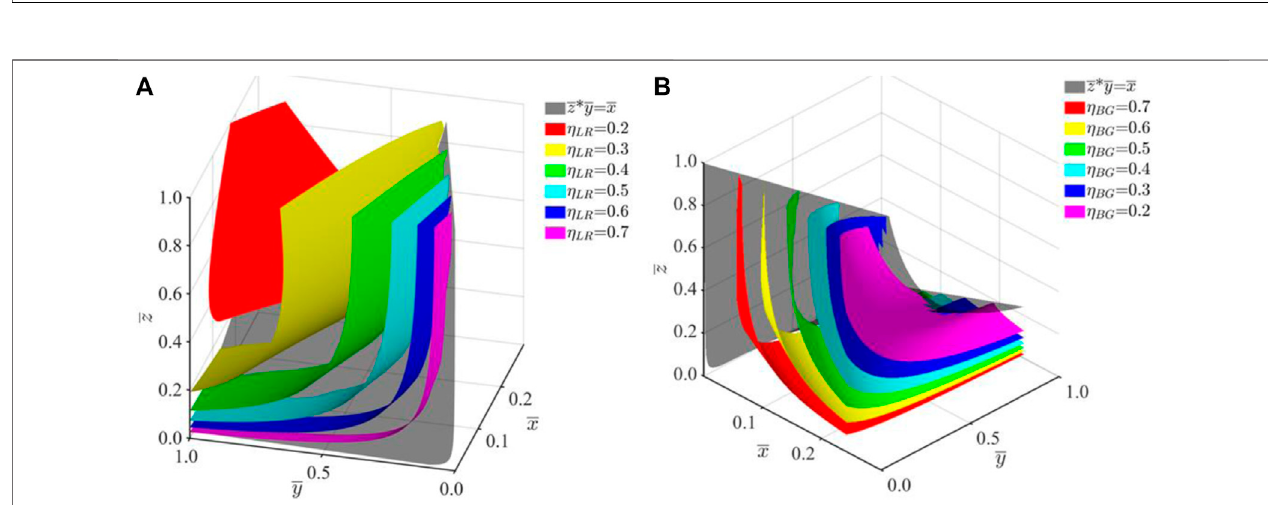
FIGURE 3 | Band structures of the mass-coupled monatomic/diatomic chain (2-DOF). (A) The anti-resonant frequency is between the adjacent frequencies at q (cid:2) 0 ( x (cid:2) 0 ) corresponding to p > 1, (B) the anti-resonant frequency line coincides with a passband curve corresponding to p (cid:2) 1, (C) the anti-resonant frequency is outside two adjacent frequencies corresponding to p < 1, (D) p < 1 and Bragg bandgap disappears.